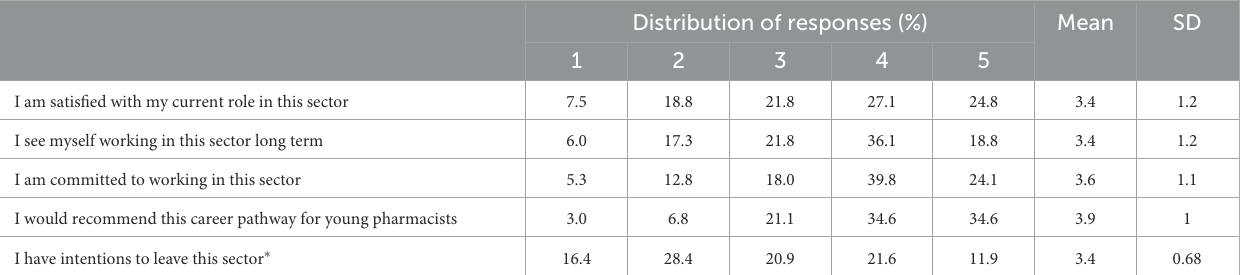
TABLE 4 Distribution of job satisfaction, work commitment, and intentions to leave ranging from 1 (strongly disagree) to 5 (strongly agree). Distribution of responses (%)